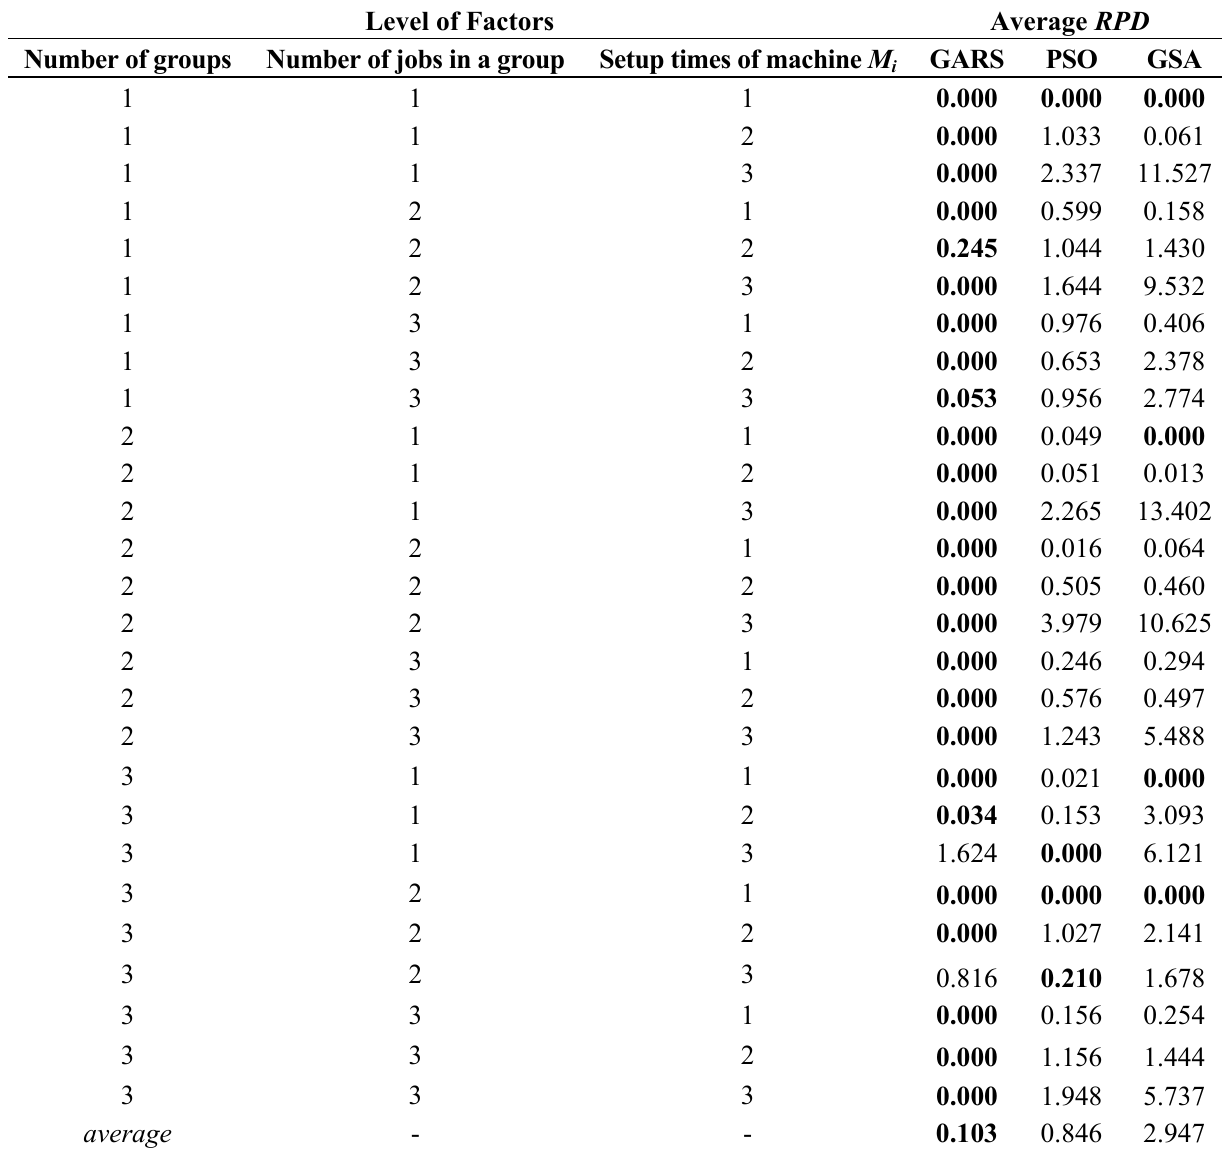
Table 7. Average Random Percentage Deviation RPD values for two-machine